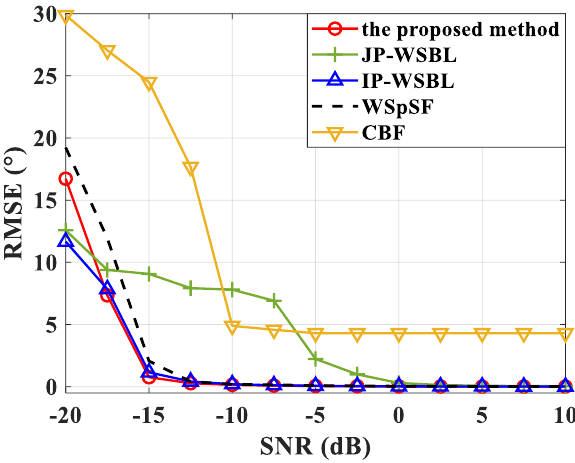
Figure 5. The RMSE versus the SNR under Case I.